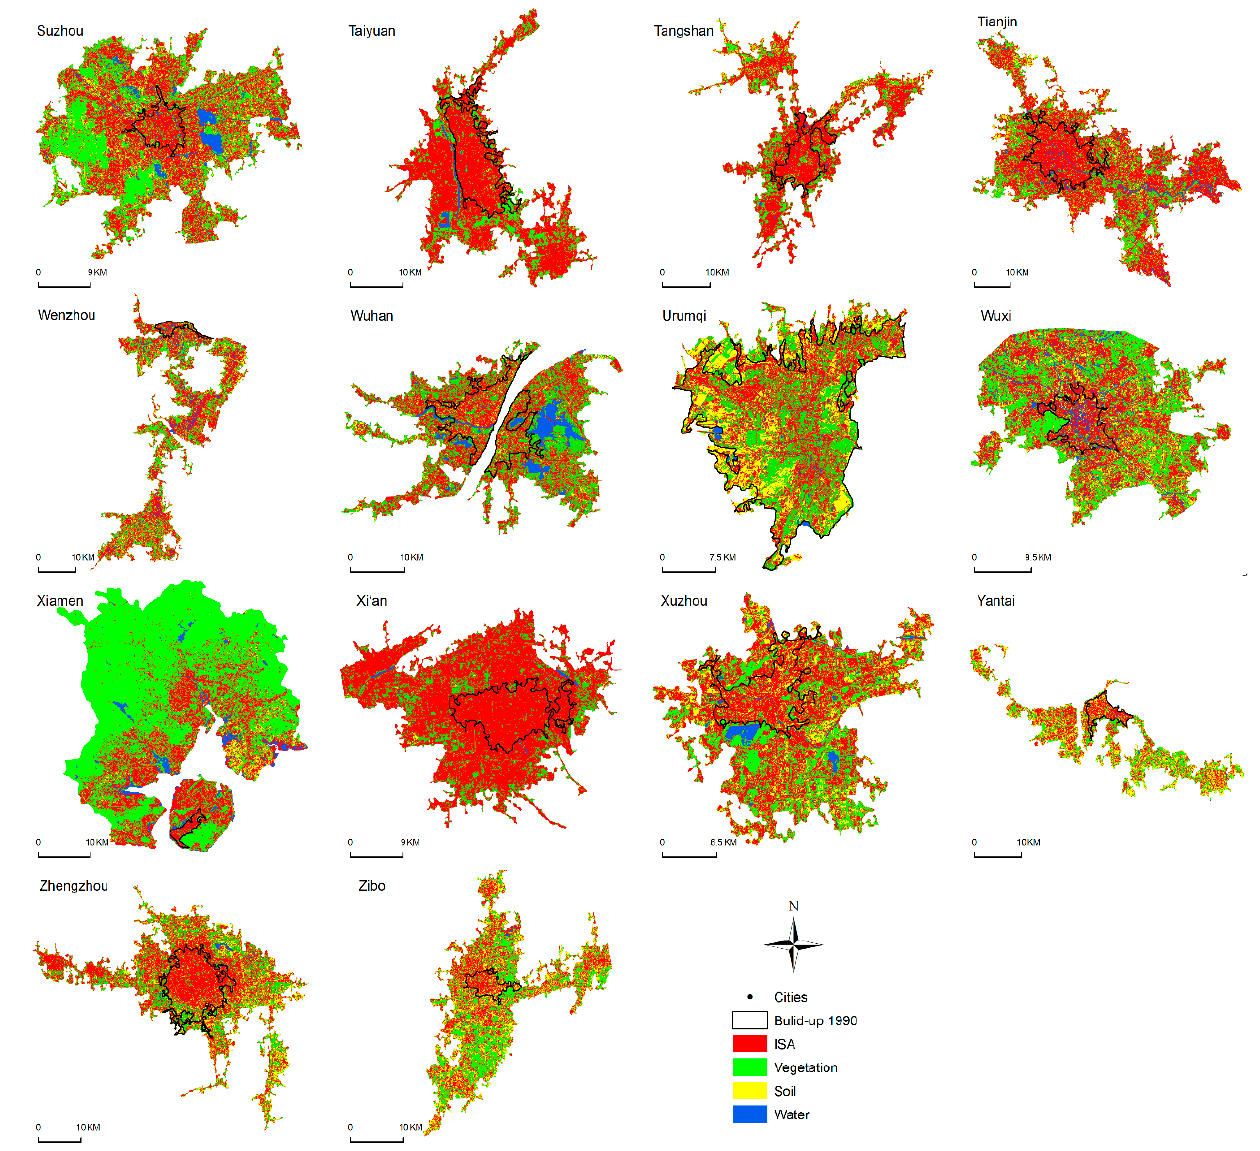
Figure 4. Land cover for the 50 major cities in China in 2015.